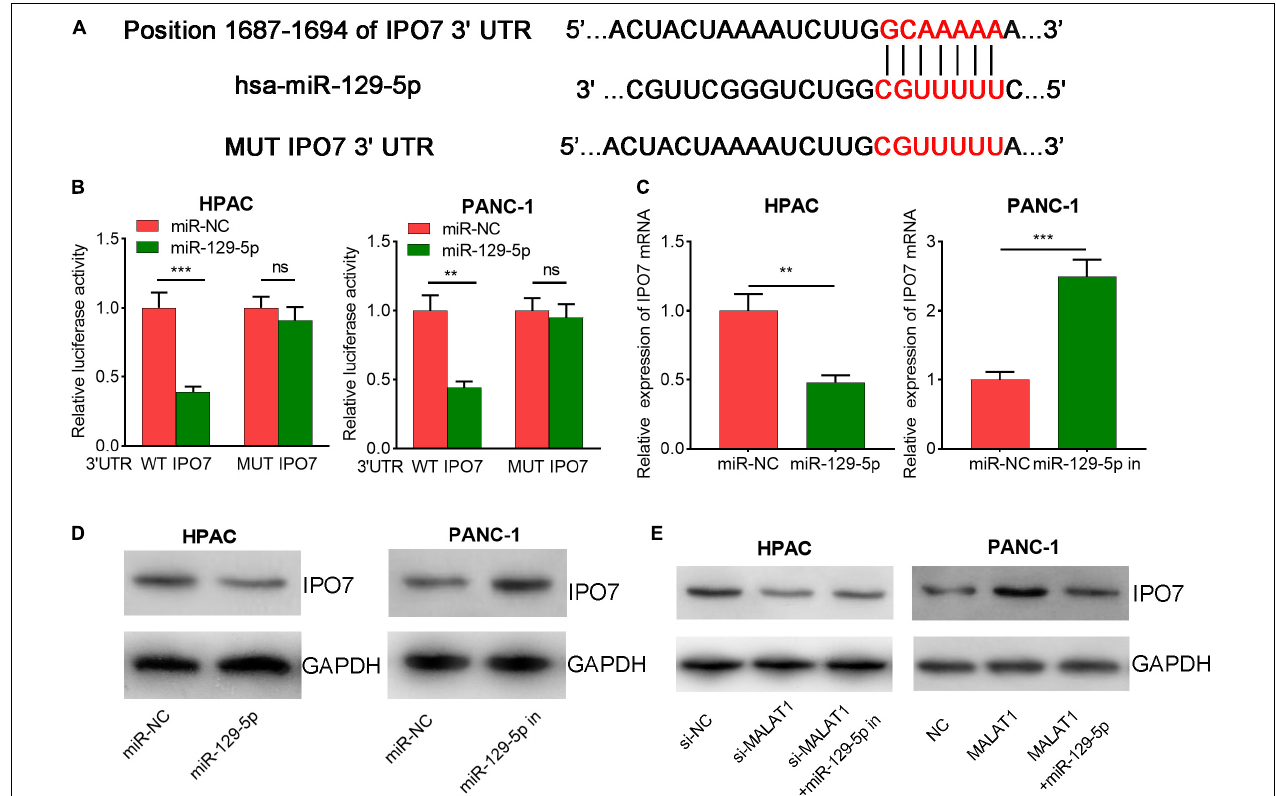
FIGURE 7 | Importin 7 (IPO7) is a direct target of miR-129-5p in pancreatic cancer cells. (A) The wild-type (WT) binding site between IPO7 3 (cid:48) -untranslated region (UTR) and miR-129-5p was shown, and the mutant (MUT) sequence was designed. (B) miR-129-5p mimics significantly suppressed the luciferase activity of reporter vector carrying wild-type (WT) IPO7 3 (cid:48) -UTR sequence, but not MUT IPO7 3 (cid:48) -UTR sequence. (C,D) qPCR and Western blot showed that miR-129-5p could negatively regulate IPO7 expression in pancreatic cancer cells. (E) Western blot showed that the positive regulation of IPO7 expression by MALAT1 could be partially weakened by miR-129-5p. * p < 0.05, ** p < 0.01, *** p <